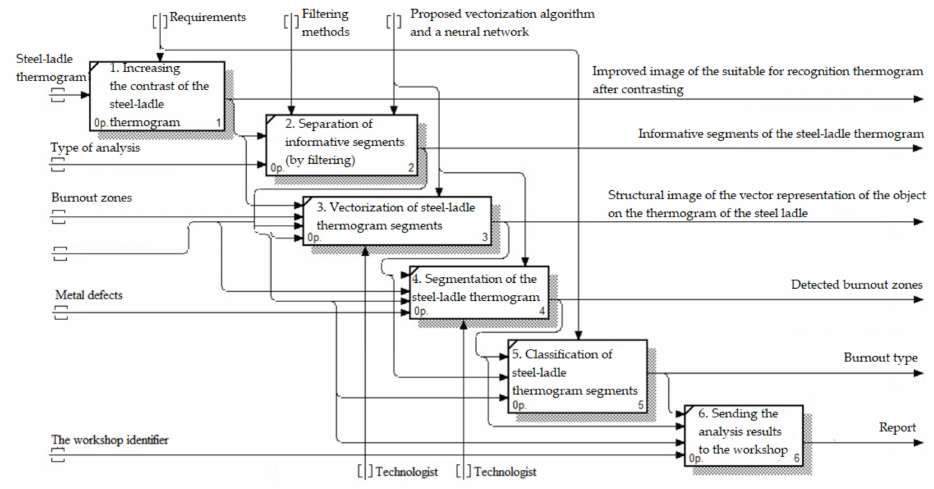
Figure 1. IDEF0 diagram of the proposed algorithm for recognizing thermograms of steel